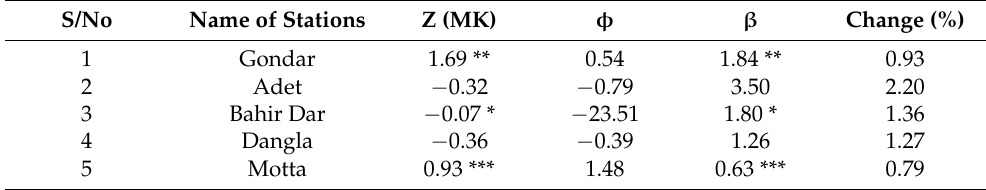
Table 3. Trends for stations in the Nile River